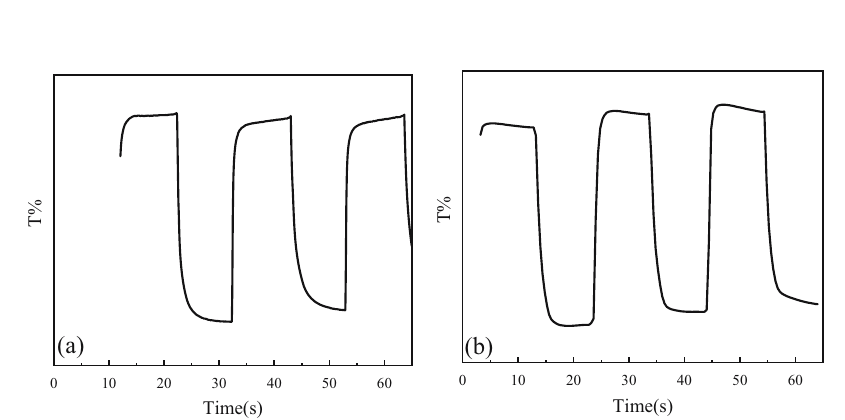
Figure 7: Kinetics of ( a ) PEDOT:PSS fi lms deposited at 1.4 V for 40 s and ( b ) PEDOT:PSS/EMI - TFSI fi lms deposited at 1.4 V for 40